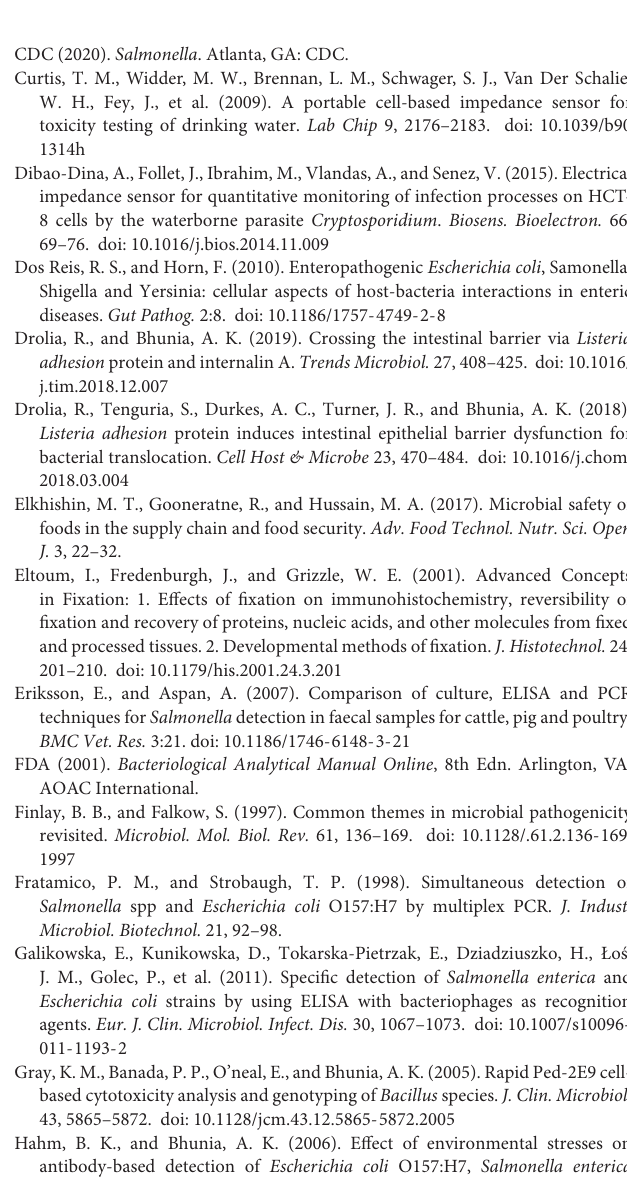
Supplementary Figure 2 | Experimental set-up of the blind test using an on-cell (MaCIA) enrichment method. (A,B) The checkerboard filled areas correspond with sample a; the diagonal stripes filled areas correspond with sample b; No pattern-filled area corresponds with negative control for each food product. The numbers in the table represent the concentration (CFU/mL) of the inoculant, S. Enteritidis PT21. (C) Blinded test using on-cell enrichment. Positive samples were inoculated with 25 CFU/mL cold-stored S. Enteritidis PT21. Neg: negative control. a, b: blind tested samples. Supplementary Figure 3 | Tryptic soy agar (TSA) plates showing the presence of background bacterial populations from different food samples except for the eggs. Supplementary Table 1 | Proposed enrichment time for different food products before testing with MaCIA. Supplementary Table 2 | Total detection time required for each method. Supplementary Table 3 | PCR primer sequences